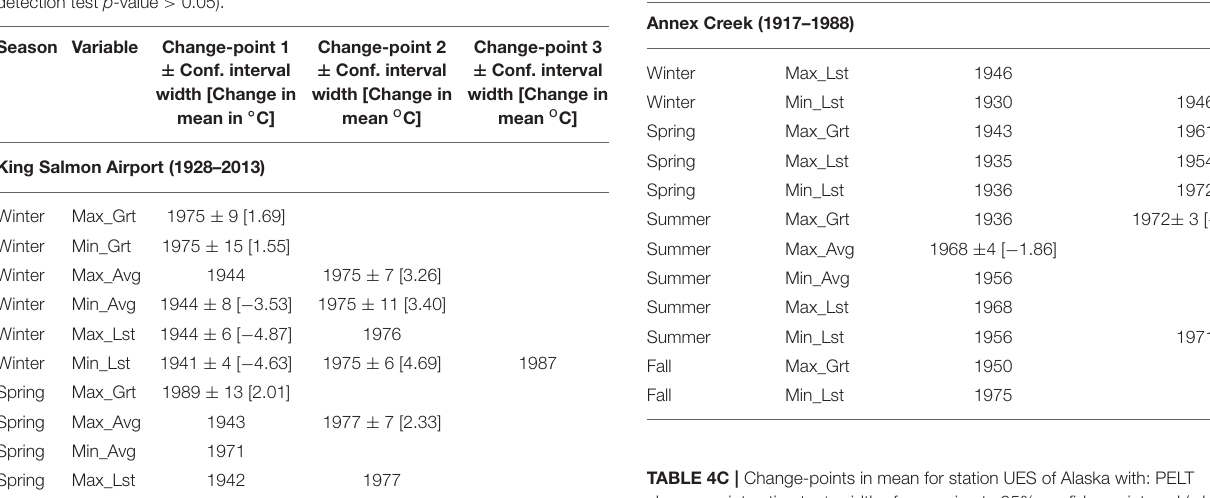
TABLE 4C | Change-points in mean for station UES of Alaska with: PELT change-point estimate ± width of approximate 95% confidence interval